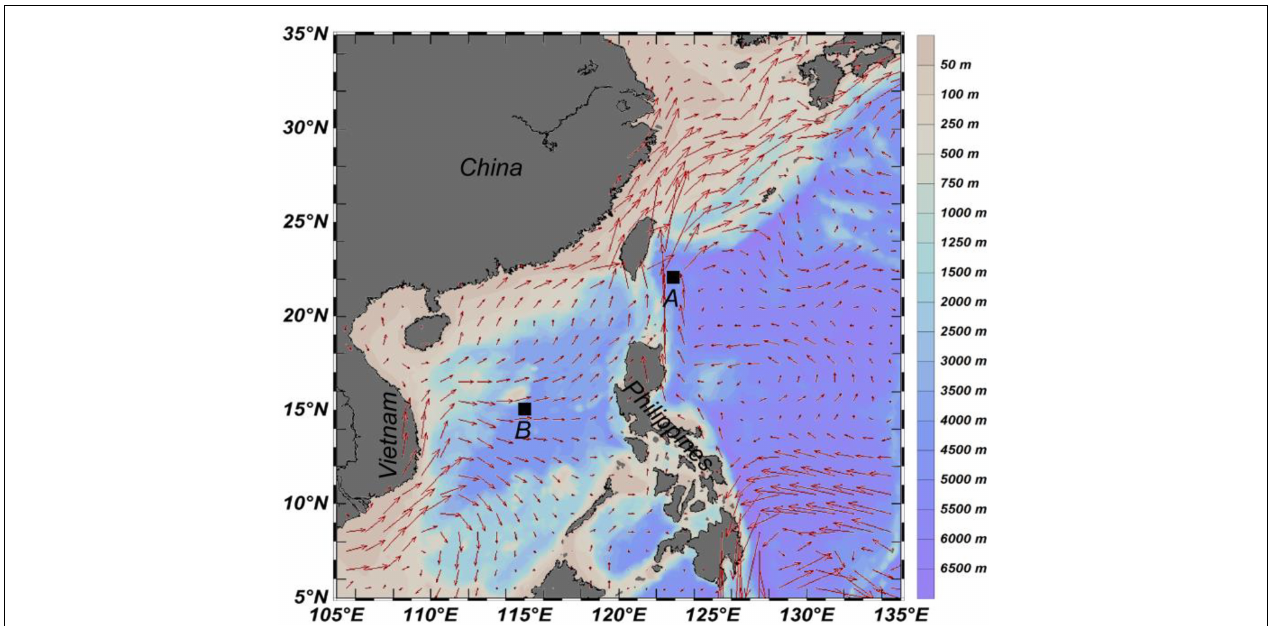
FIGURE 1 | Sampling stations and surface currents in the investigating